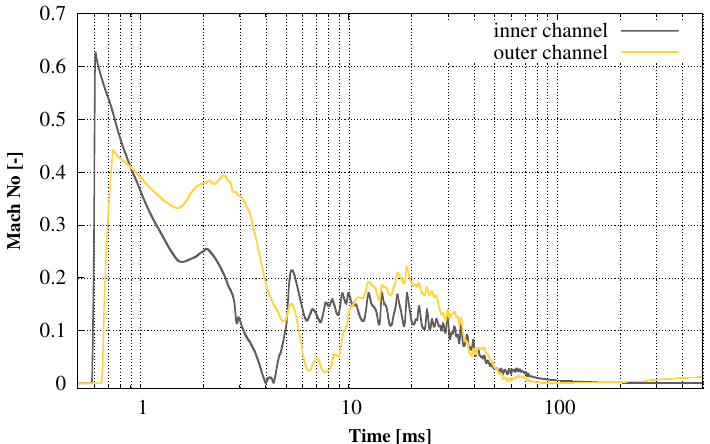
Figure 12. Mach number distribution at the outlet channels.